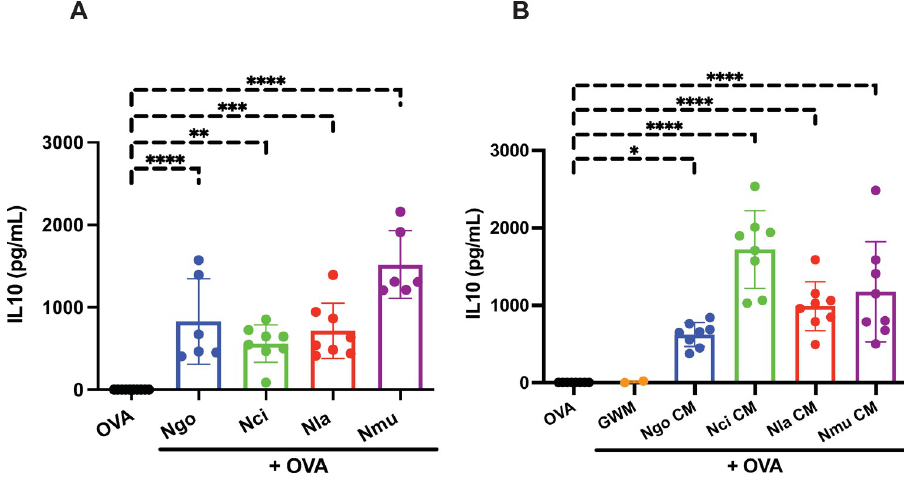
Fig 4. Live bacteria and conditioned medium prepared from four Neisseria species up-regulated IL10 secretion in DCs. Dendritic cells were exposed to (A) whole live bacteria ( N . gonorrhoeae ( Ngo ), N . lactamica ( Nla) , N . cinerea ( Nci ), or N . mucosa (Nmu) ), or (B) conditioned medium ( Ng -CM, Nla -CM, Nci -CM, or Nmu -CM) in the presence of OVA for 24 hours, at which time IL-10 secretion was measured using ELISA. Bar graphs are shown as mean concentrations of IL10 (pg/ml) ± standard deviation with individual points. Statistical significance was determined by one-way ANOVA with Dunnett analysis for multiple comparisons ( * , P < 0.05; ** , P < 0.01; *** , P < 0.001; and **** , P <